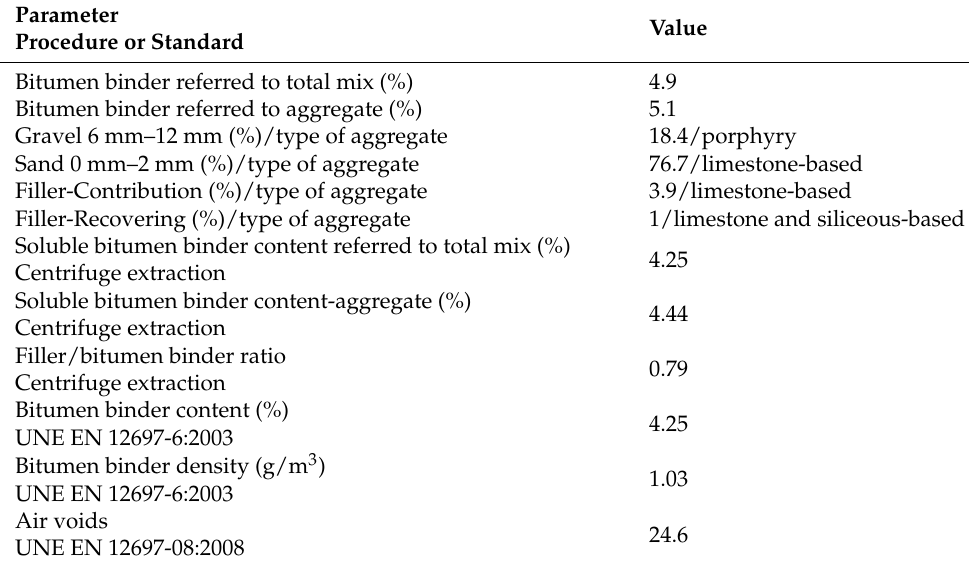
Table 3. Physico-chemical and mechanical characteristics of the asphalt